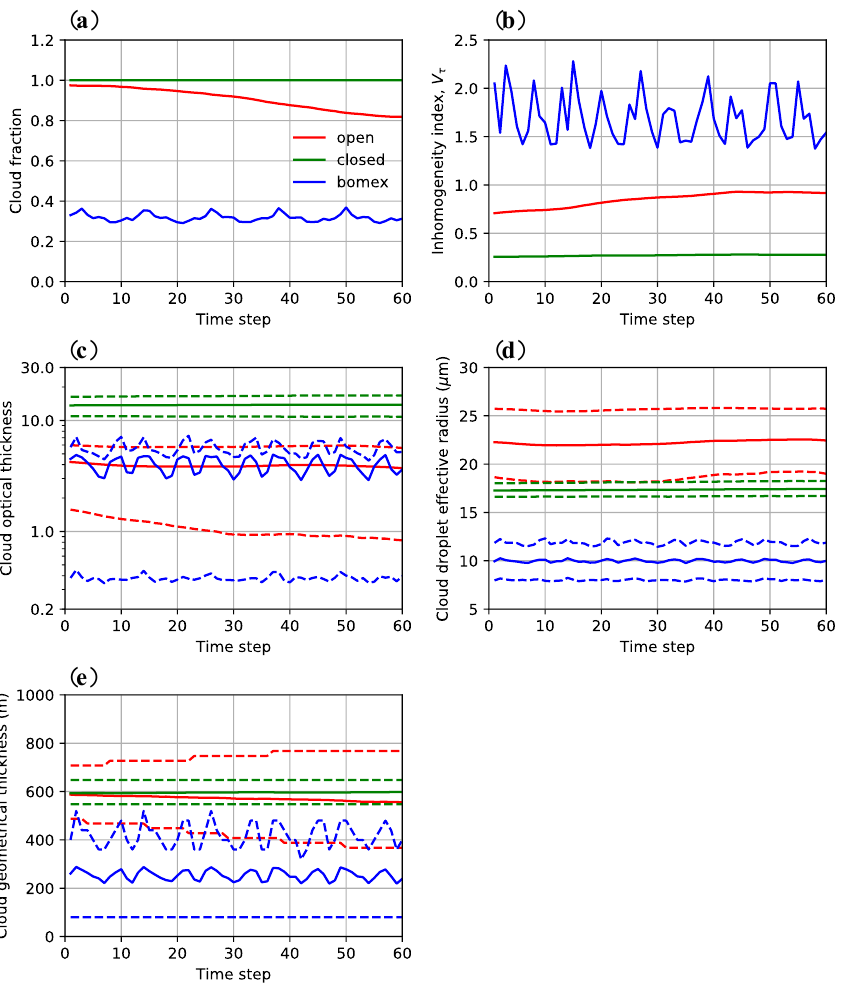
Figure A1. Temporal variations of cloud physical properties in the three cases simulated by the SCALE-LES model, namely: ( a ) cloud fraction; ( b ) the horizontal inhomogeneity index defined in Equation (5). ( c,d,e ) Domain average (solid lines) and 20th and 80th percentiles (dashed lines) of cloud optical thickness, column-mean droplet effective radius, and cloud geometrical thickness, respectively, calculated for the cloudy columns. All of the calculations are made by assuming that cloudy columns have a COT greater than or equal to 0.1.